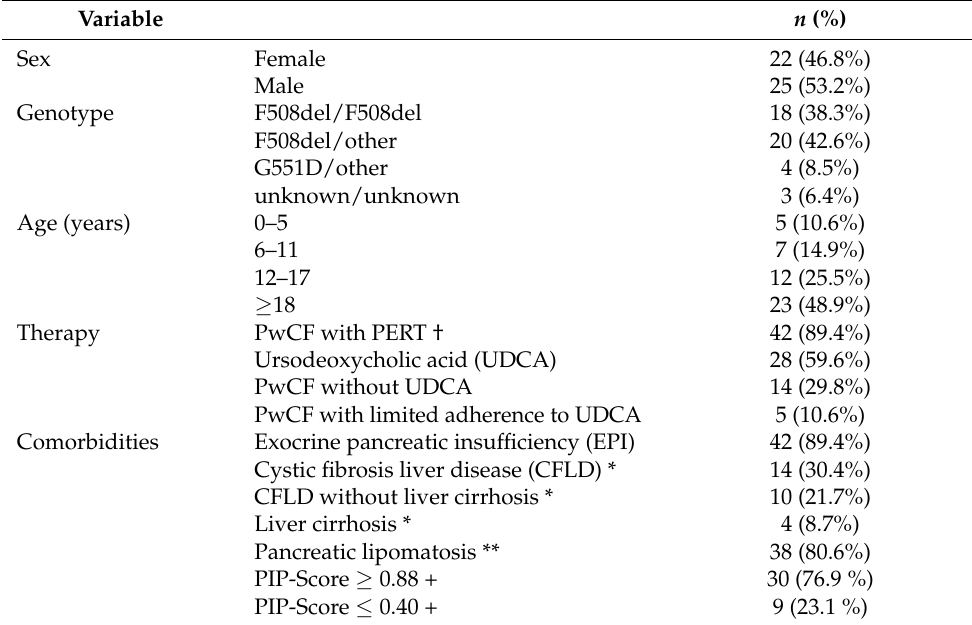
Table 1. Demographic characteristics of the included people with CF (pwCF) ( n =